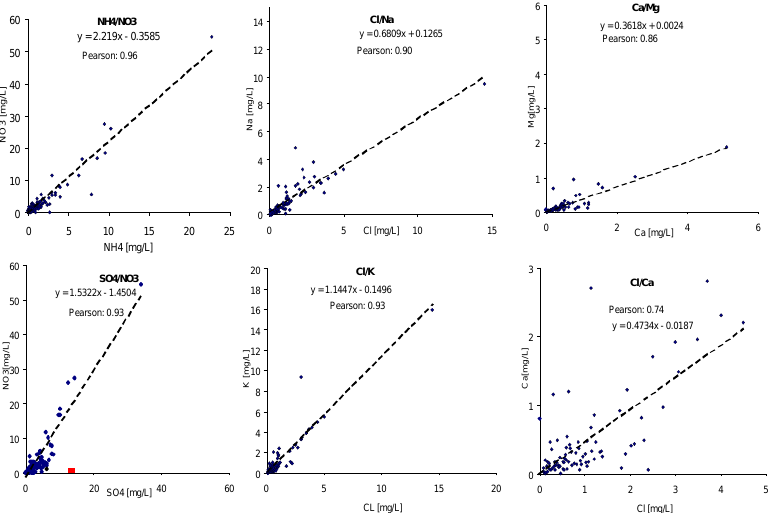
Figure 6: Fig. 6. Correlation plots for normalized ion concentrations NH 4 /NO 3 and NH 4 /SO 4 (left), Cl/Na and Cl/K (middle), Ca/Mg and Ca/Cl (right).